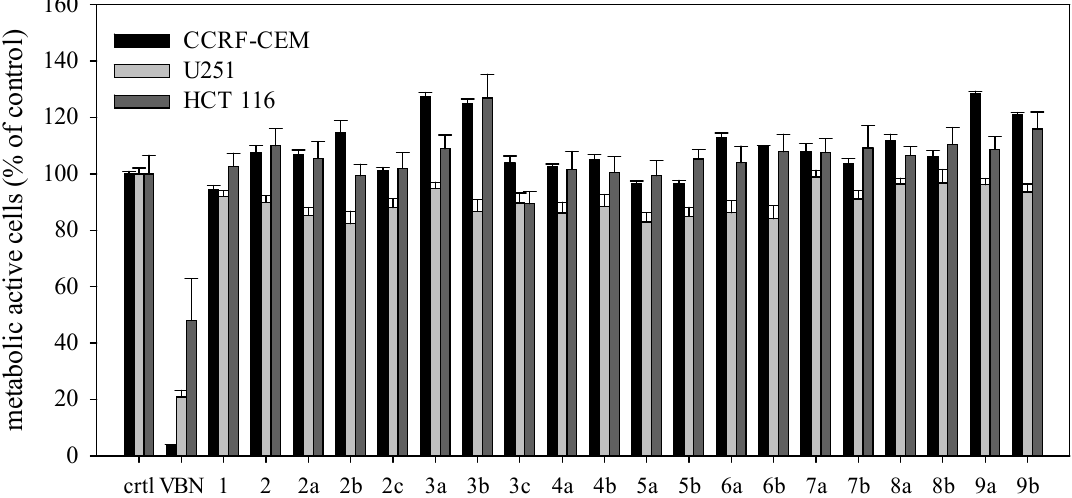
Figure 1. Effects of honokiol and tetrahydrohonokiol derivatives on cancer cell lines. Cells were incubated with the compound of interest for 72 h (n = 6). Metabolic activity of the cells was measured using the XTT viability assay. Vehicle-treated cells (crtl, 0.5% DMSO) served as control, vinblastin (VBN) as positive control (0.01 µM). No cytotoxicity was found for any tetrahydrohonokiol derivative at 10